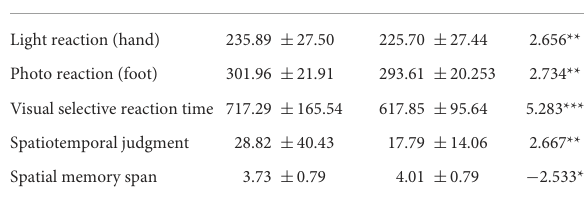
TABLE 4 Comparison of motor cognitive ability between disabled and able-bodied